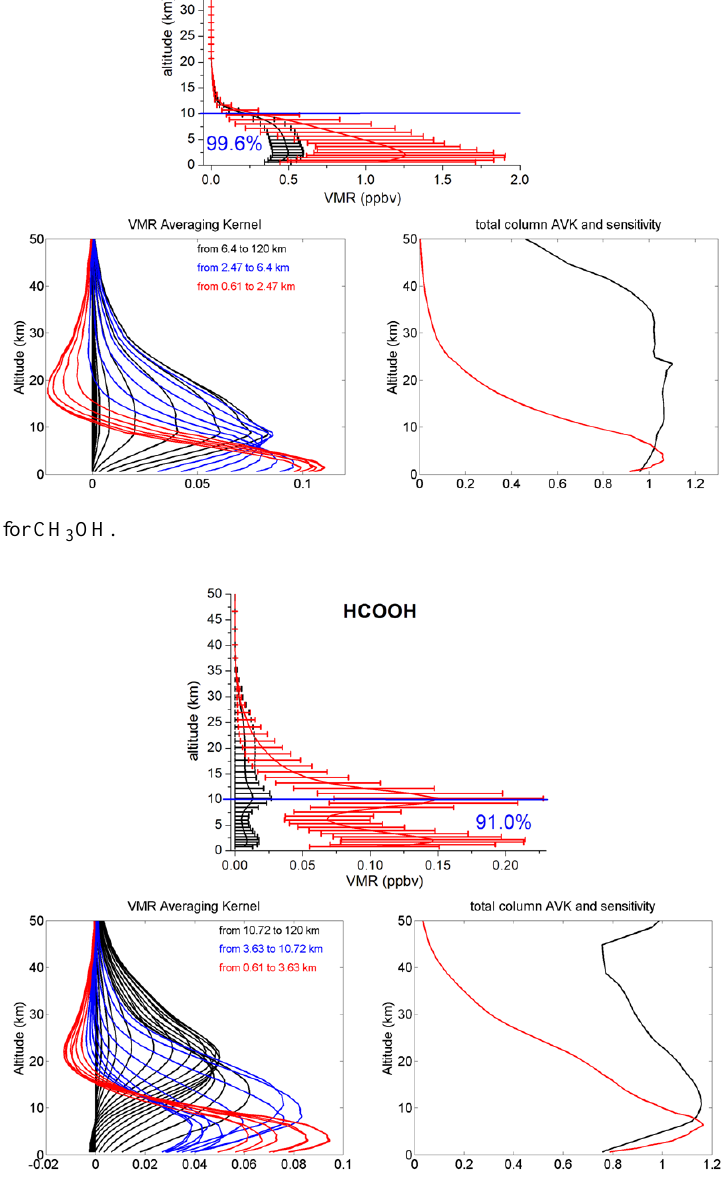
Figure 8. Same as Fig. 3 but for